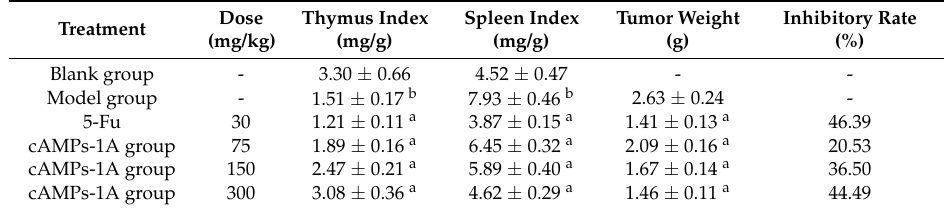
Table 1. Inhibitory effect of cAMPs-1A on the immune organs indexes and growth of H22 tumor.